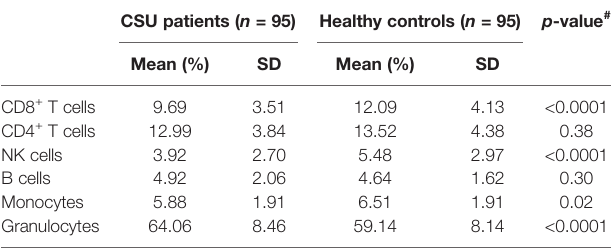
TABLE 1 | Comparisons of the percentages of the leukocyte components in the CSU patients and the healthy controls. CSU patients ( n = 95) Healthy controls ( n = 95) p -value #